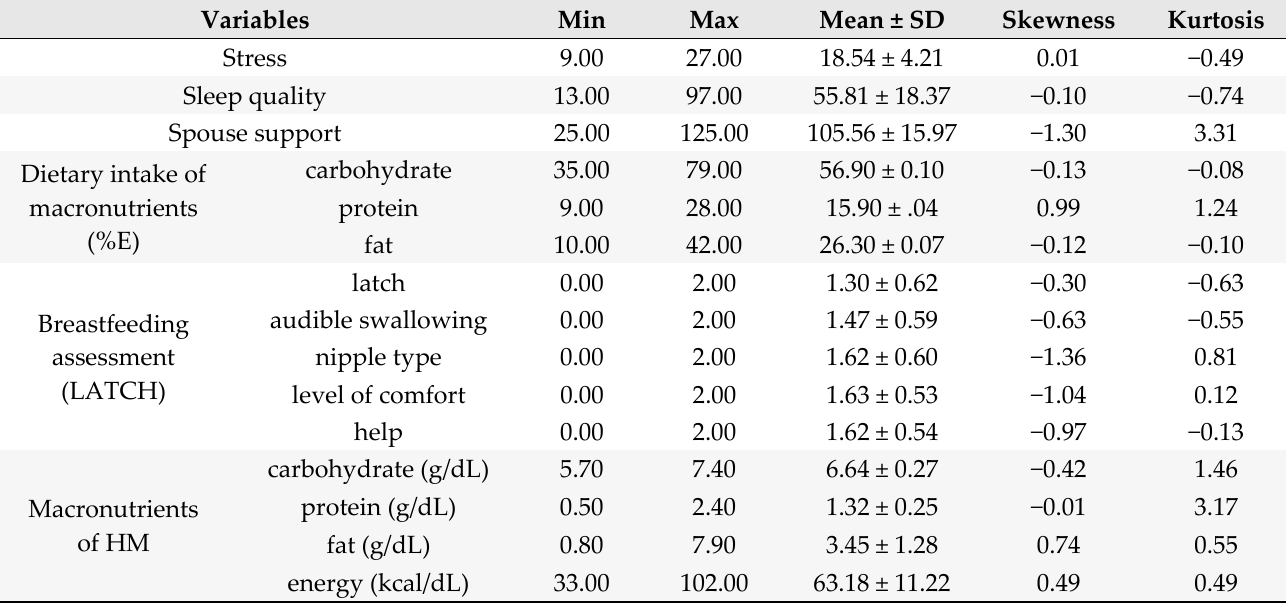
Table 2. Descriptive statistics of the main variables ( n = 159).